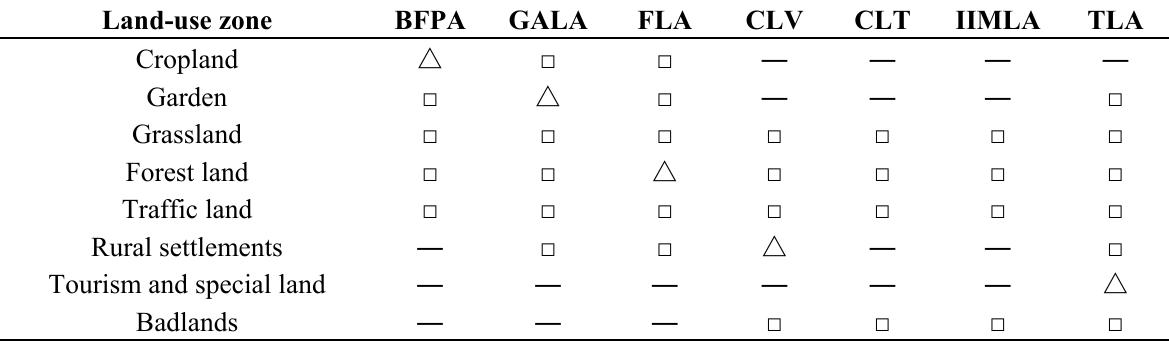
Table 5. The dominant land use, allowable land use, and prohibited land use of the various land-use zones.